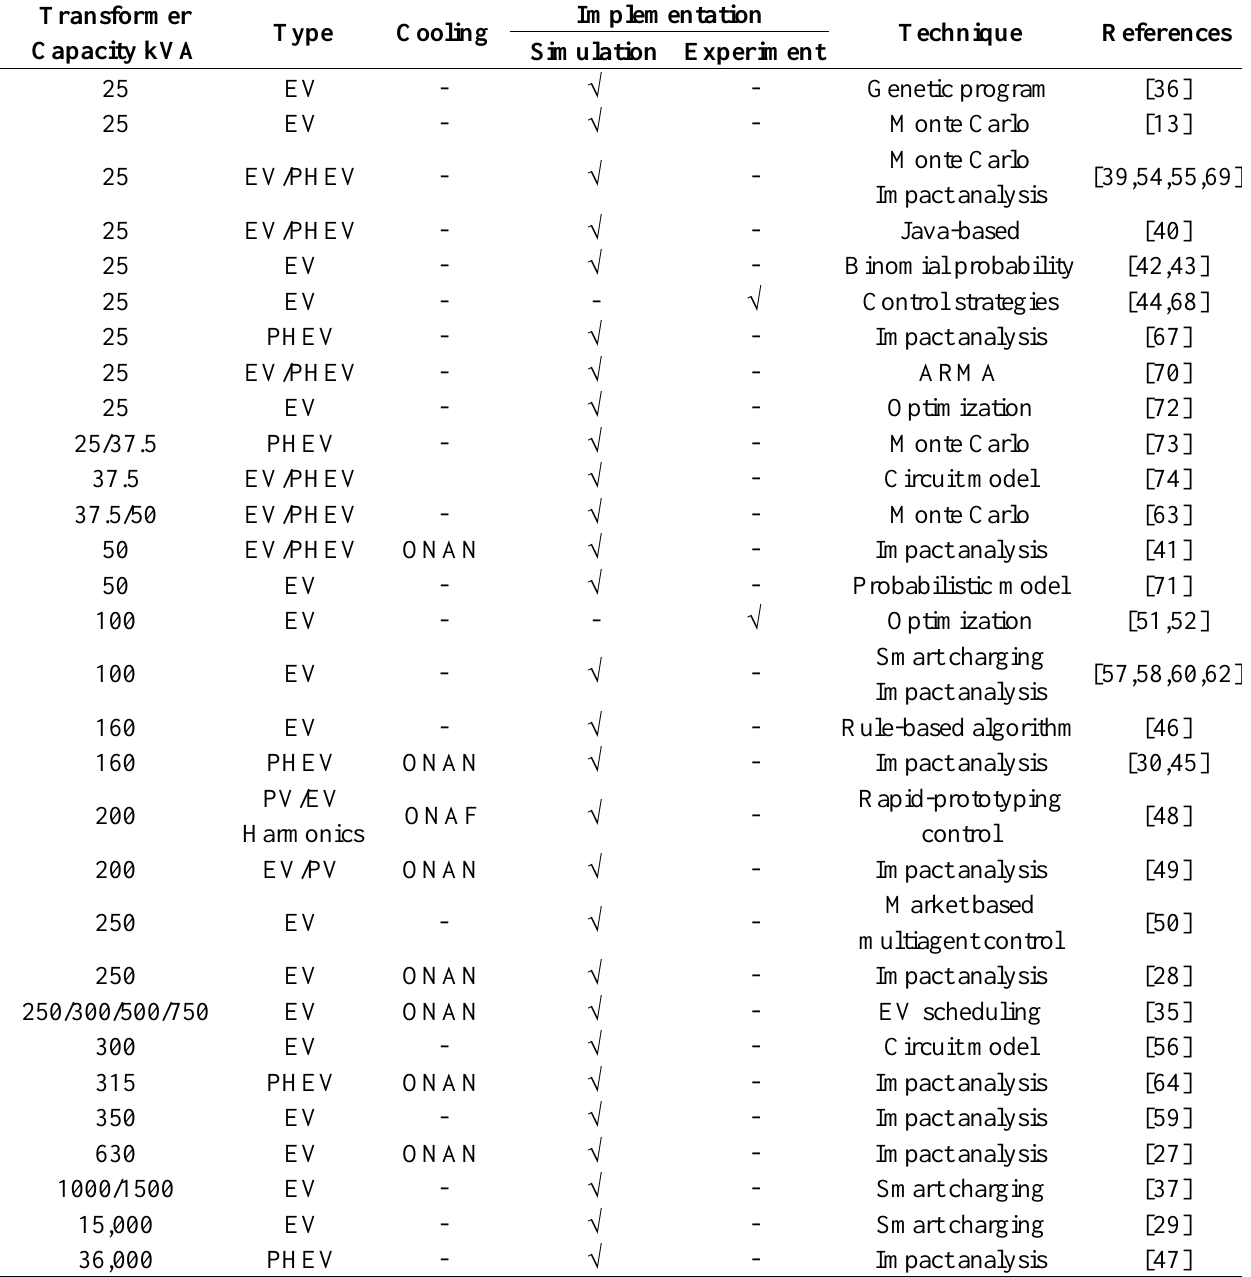
Table 7. Transformer types and info concerning EV